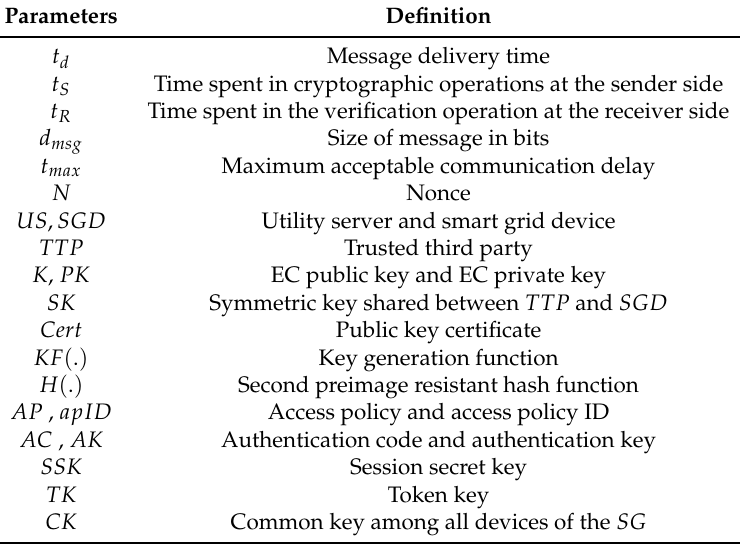
Table 1. Notation